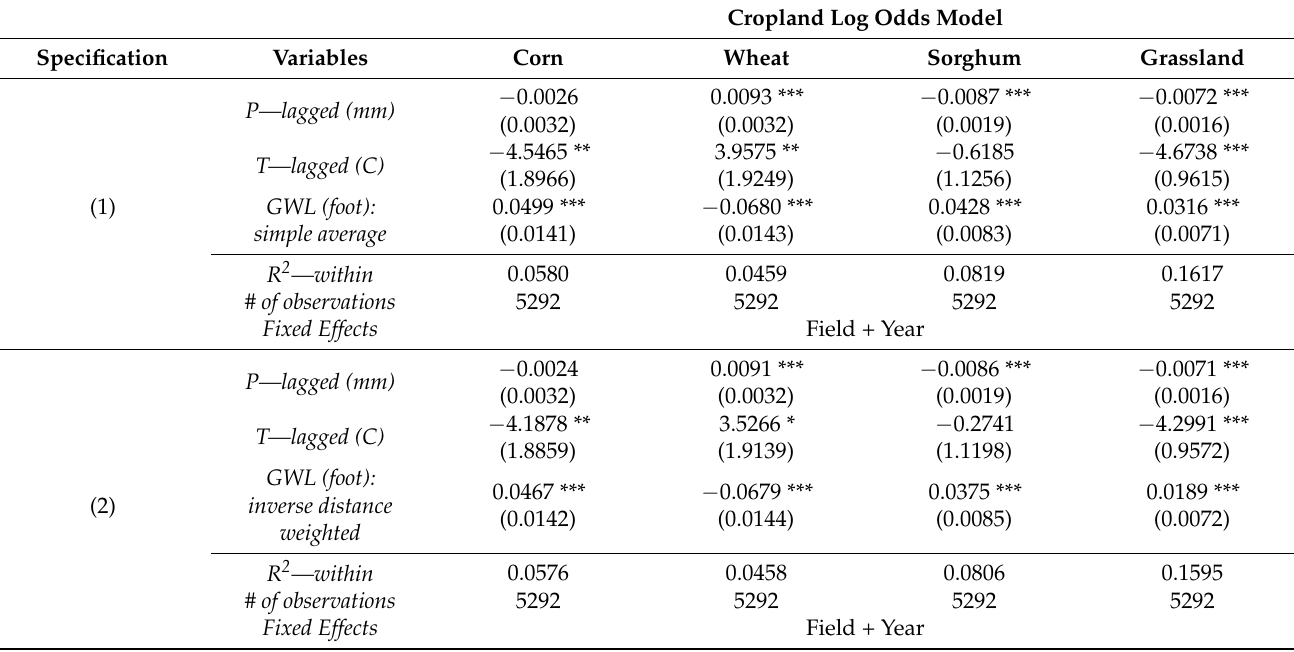
Table 2. Estimation results from the (panel data) two-way fixed-effects